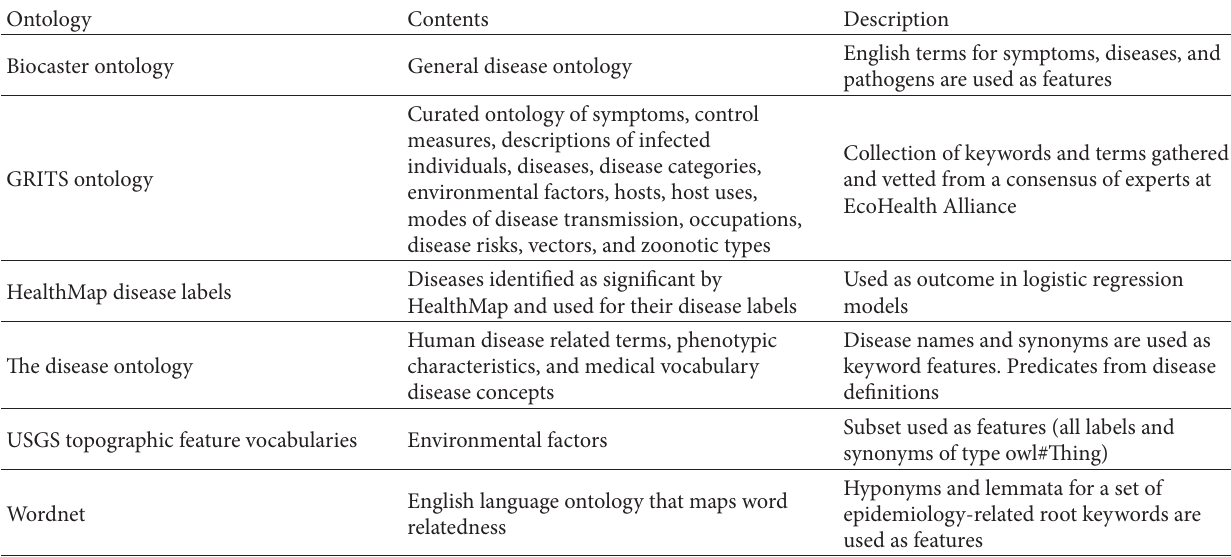
Table 1: The ontologies used in GRITS, their contents, and their